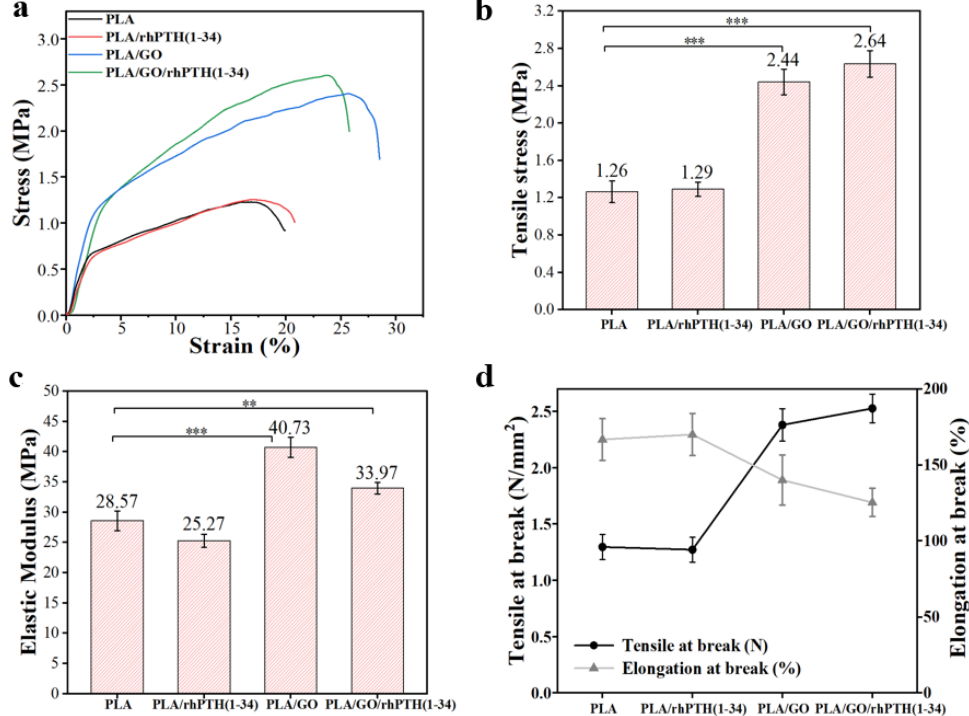
Figure 3. Tensile behavior of PLA, PLA/rhPTH(1-34), PLA/GO and PLA/GO/rhPTH(1-34) electro- spun membranes. ( a ) Typical stress-strain curves; ( b ) tensile stress (Notes: *** p < 0.001); ( c ) elastic modulus (Notes: *** p < 0.001, ** p < 0.01); ( d ) tensile strength and elongation percentage. The average values and error bars are marked.